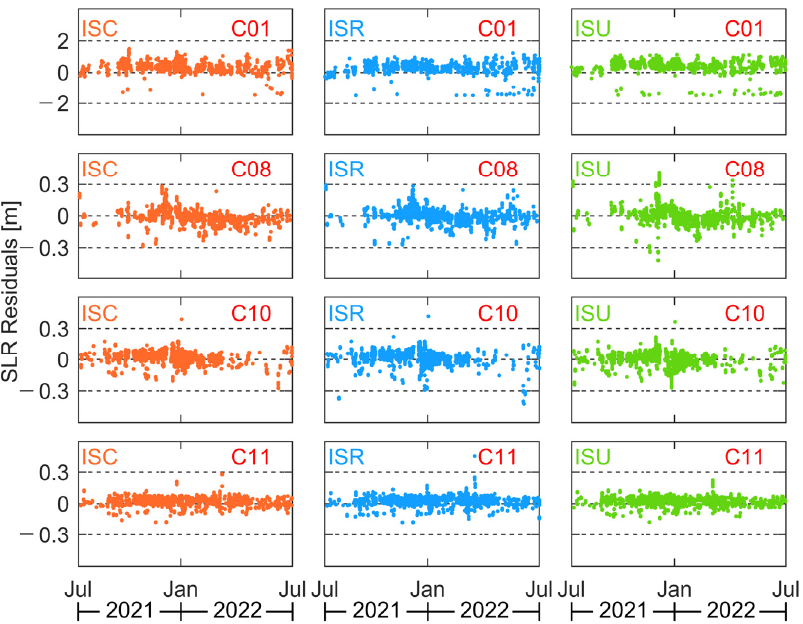
Figure 12. SLR residuals of BDS-2 satellites based on three types of iGMAS B1I/B3I orbits .